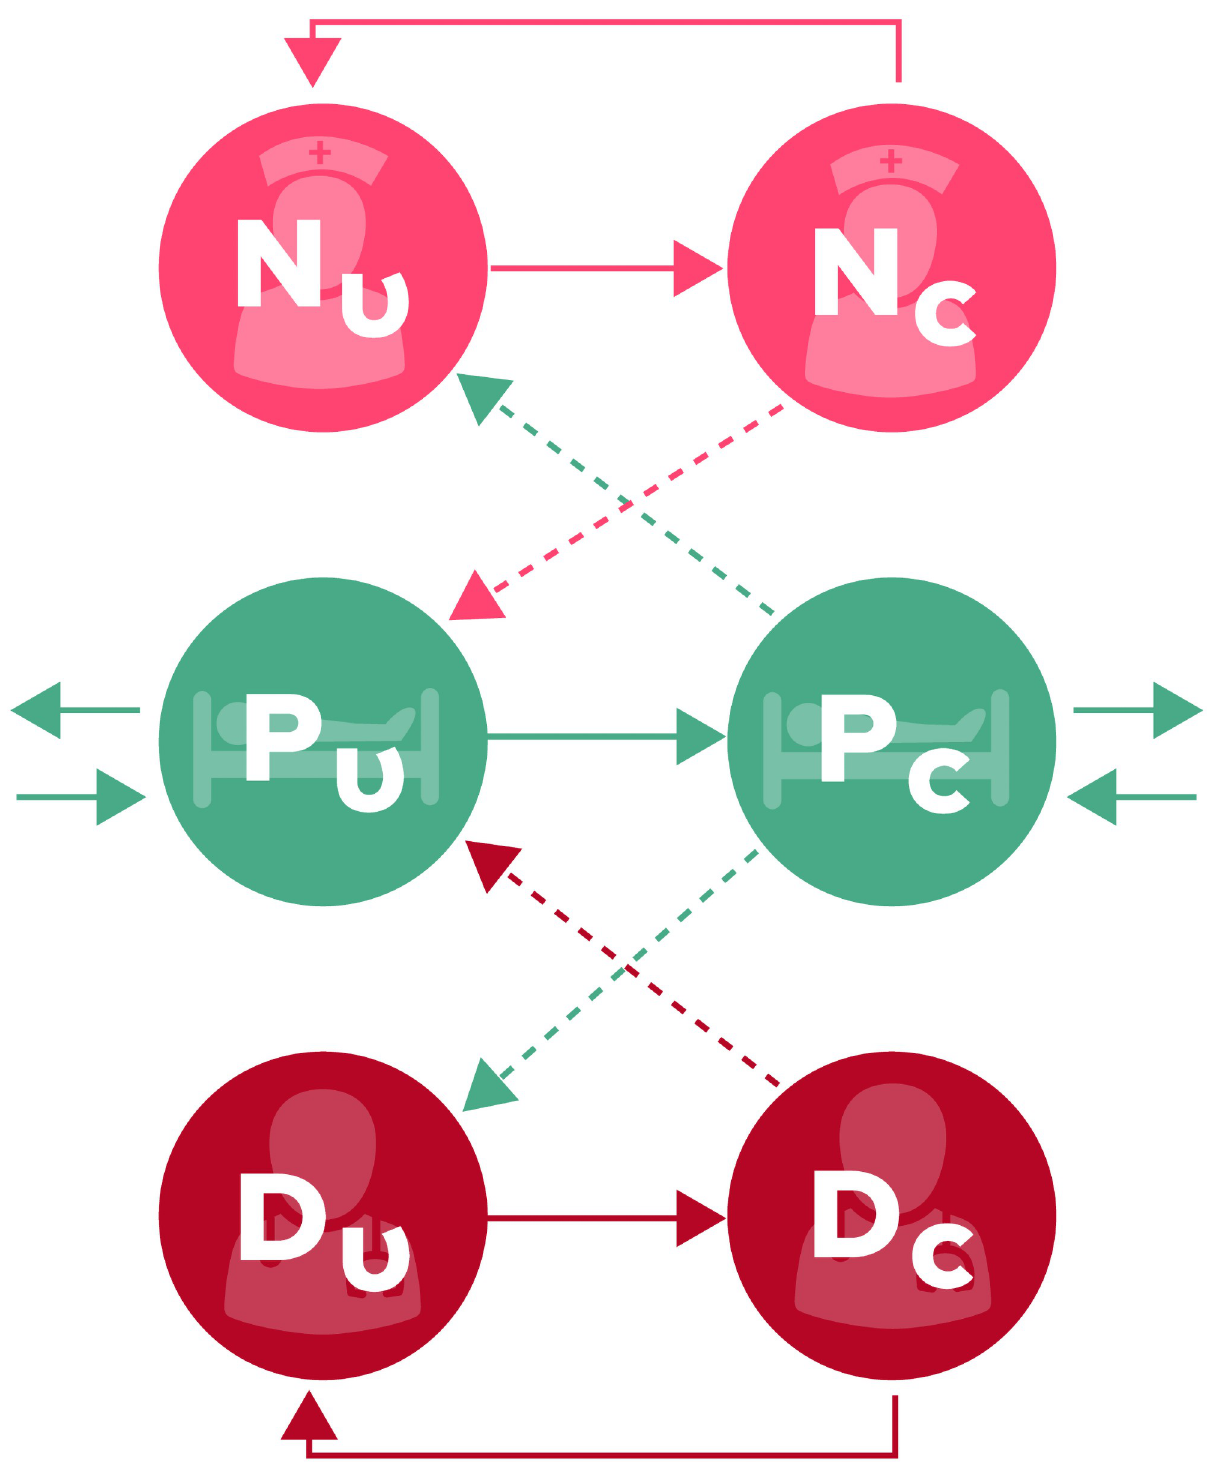
Fig 1. Schematic representation of the compartmental flow of a mathematical model of methicillin-resistant Staphylococcus aureus (MRSA) acquisition with nurses and intensivists separated into different staff types. Solid arrows indicate possible transition states, while dashed arrows indicate potential routes of MRSA contamination or colonization. Nurses and doctors are classified as uncontaminated ( N U or D U ) and contaminated ( N and D ), while patients are classified as uncolonized ( P ) or colonized ( P ). Figure by Eric Lofgren is licensed under CC BY 4.0. C C U C